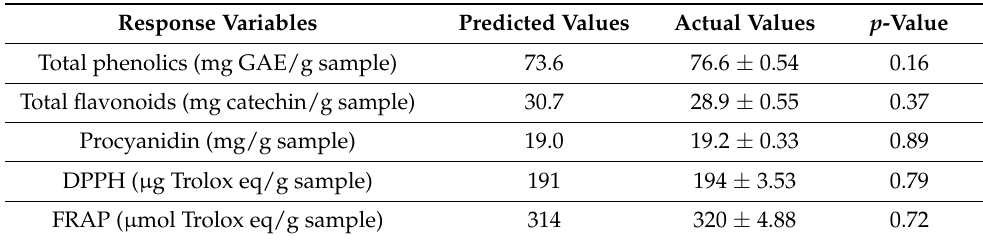
Table 3. Predicted and actual response values obtained at optimal extraction conditions (40 ◦ C and a liquid-to-solid ratio of 25:1).